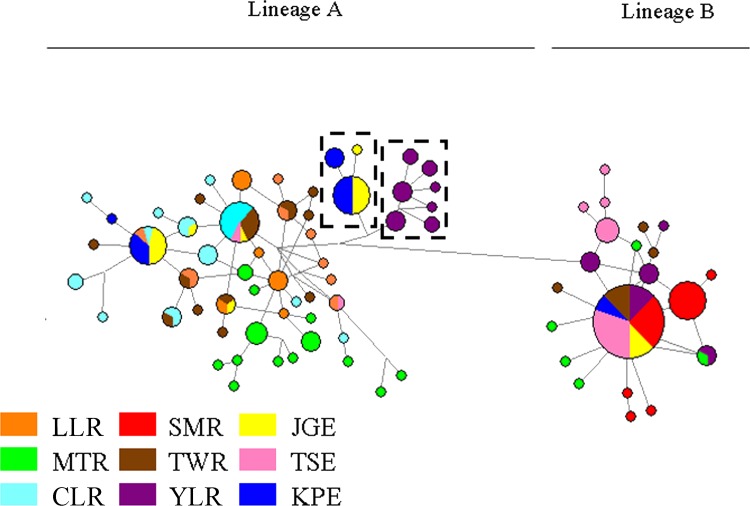
The haplotype network of Macrobrachium nipponense in all sampling sites.